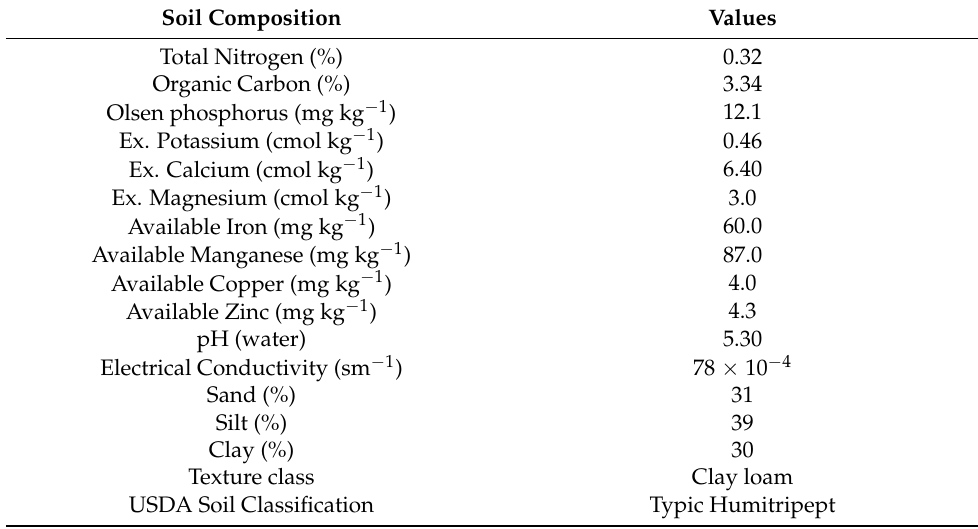
Table 1. The soil chemical and physical properties used for the experiments. Soil